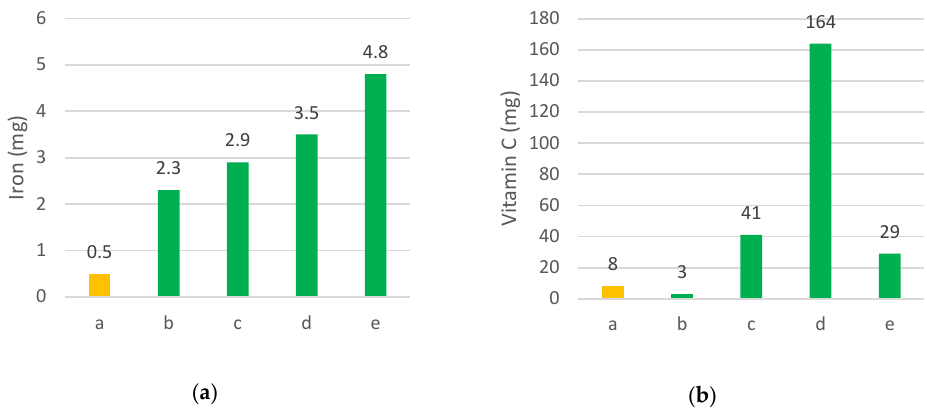
Figure 4. Four wild leafy vegetables from West Sumatra are compared to common lettuce ( Lactuca sativa ) in terms of ( a ) iron content (mg) and ( b ) vitamin C content (mg). In the graphs the letters stand for a lettuce; b vegetable fern “pakis” ( Diplazium esculentum ); c nightshade “leunca / ranti” ( Solanum americanum ), d sweet leaf “katuk / nasi-nasi” ( Sauropus androgynus ), and e water mimosa “komen” ( Neptunia prostrata ). Values are expressed per 100g of fresh, raw ingredient. Source : Indonesian Food Composition Data